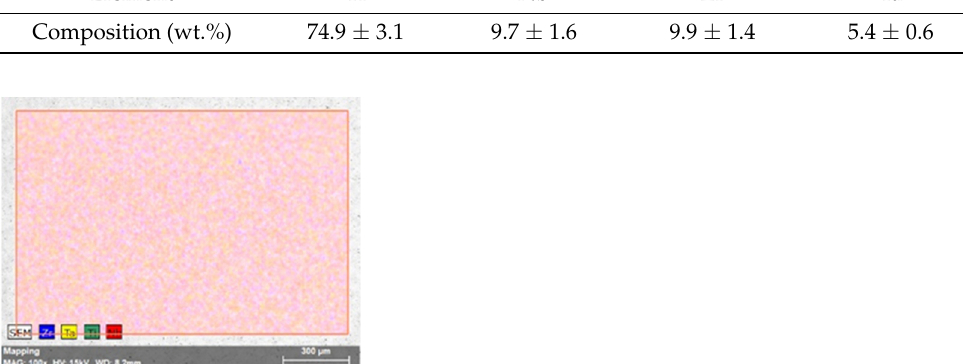
Table 2. The elemental composition of the Ti–10Nb–10Zr–5Ta alloy. Element